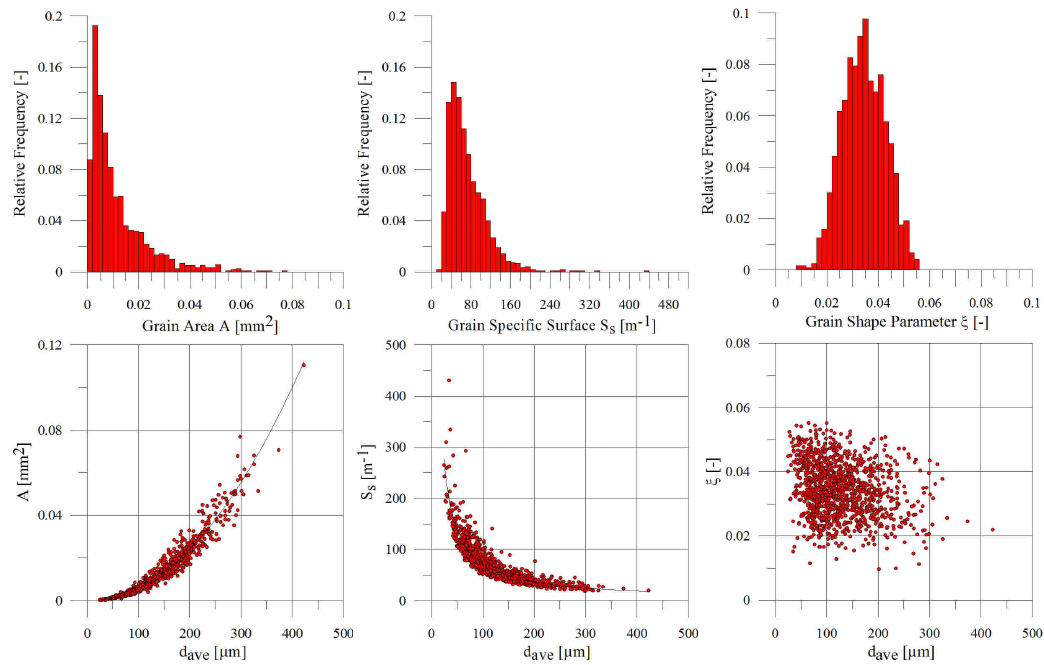
Figure 3: Frequency distributions and distribution as a function of average grain size d ave for the three thin sections of the following grain geometric parameters: area A, specific surface S s and shape parameter 